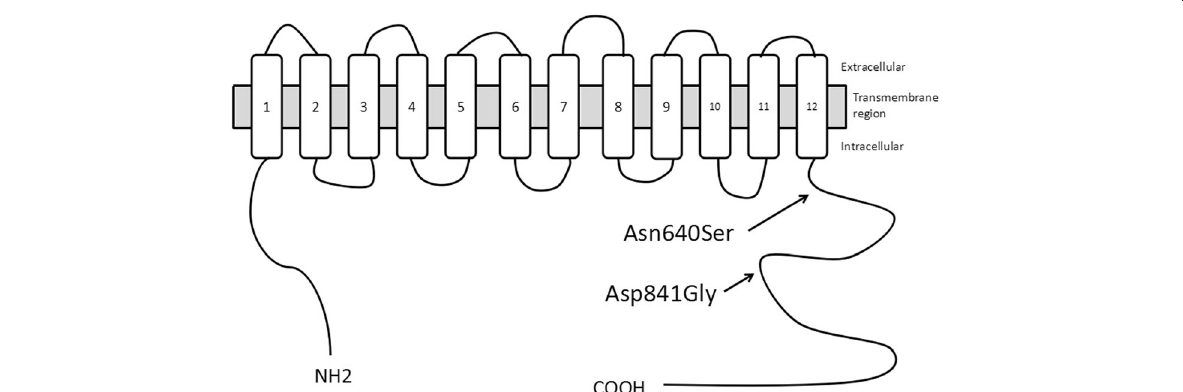
Fig. 3 Predicted topological localization of Na-Cl cotransporter (NCC) mutations. Schematic representation of NCC protein with the intercellular N- and C-terminal domains and with squares 1 to 12 indicating the 12 transmembrane segments. [ 9 ] Arrows indicate the position of the selected mutations